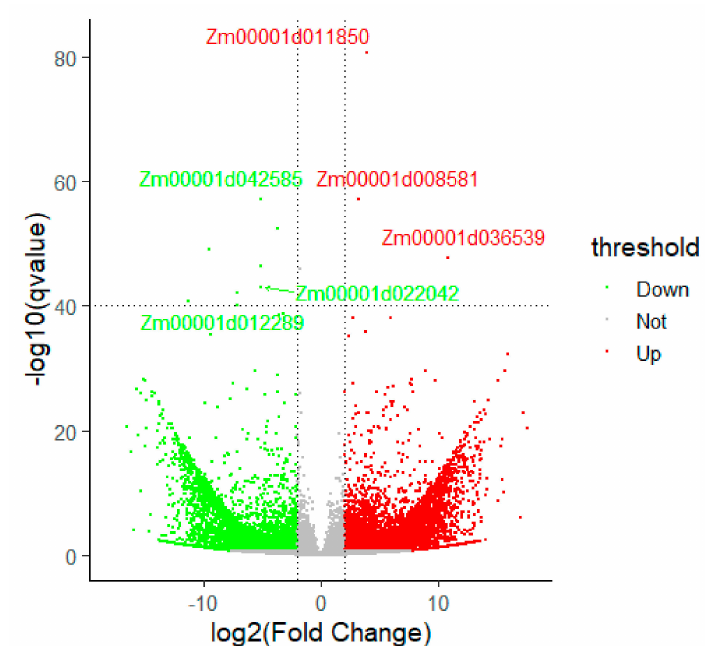
Figure 3. Functional classification of di ff erentially expressed genes. Red dots indicate up-regulated genes and green dots indicate down-regulated genes under significant levels of Padj < 0.05 and Log 2 fold change >